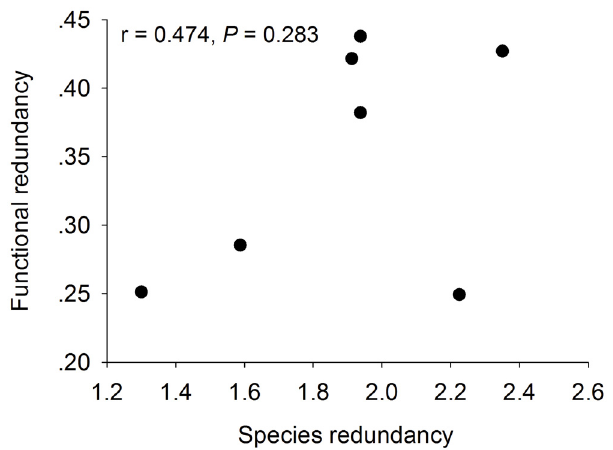
Fig 3. Species redundancy and functional redundancy showed no